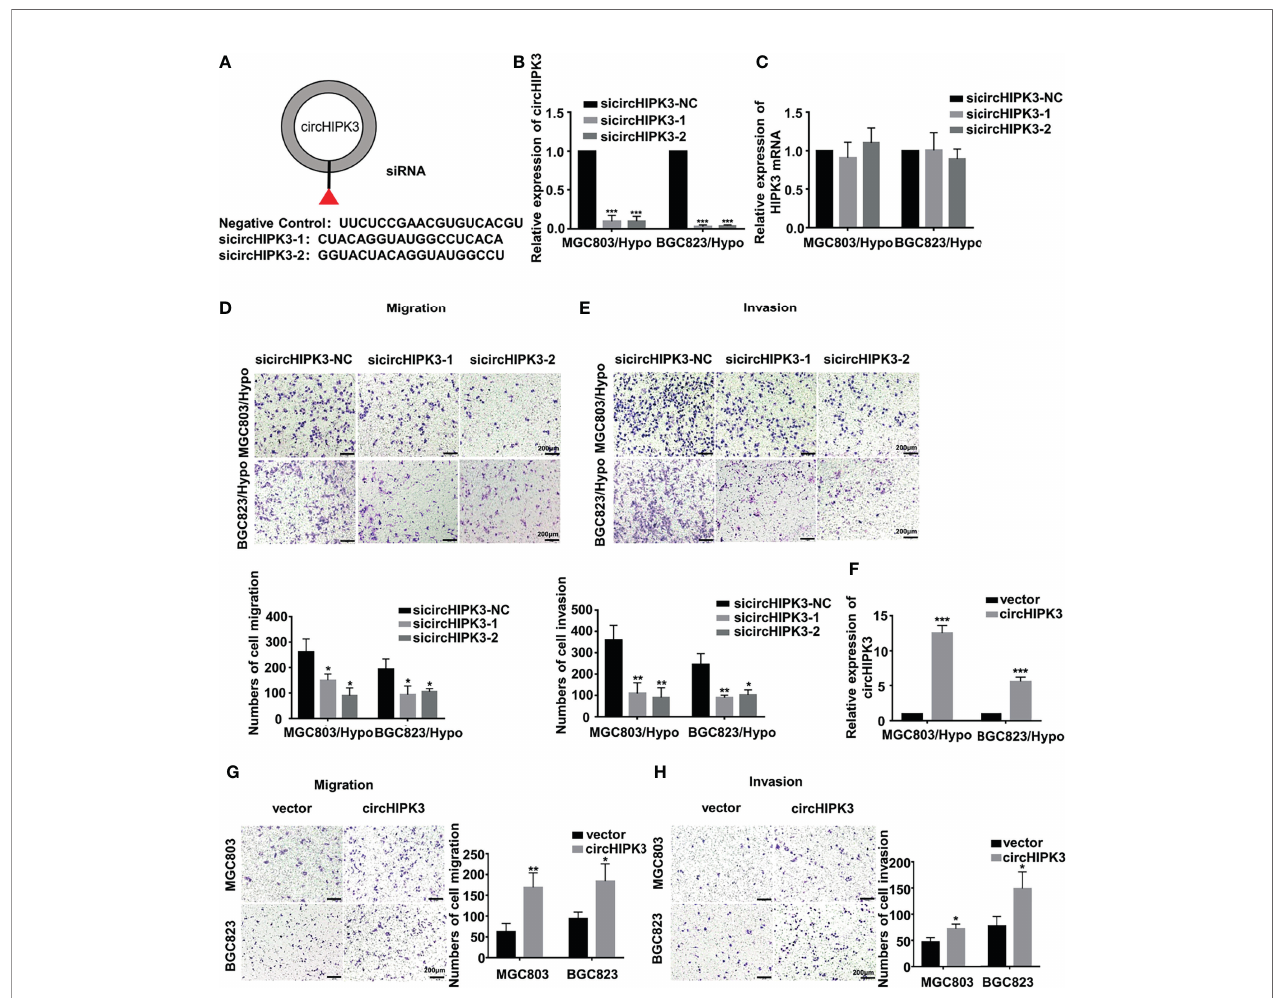
FIGURE 2 | CircHIPK3 promoted migration and invasion of HRGC cells. (A) The sequence of two siRNAs targeted to back-splicing site of circHIPK3 and the negative control siRNA. (B, C) The relative expression of circHIPK3 and linear HIPK3 mRNA in HRGC cells after transfected with negative control siRNA (siNC) or circHIPK3 siRNAs was detected by qRT-PCR. 18S was used as an internal control. (D, E) The migration and invasion ability of HRGC cells after transfected with siNC or circHIPK3 siRNAs was examined by transwell assay (original magni fi cation, 100×). The columns on the down panels are quanti fi ed by counting 3 fi elds, and presented as the mean ± standard deviation. *p < 0.05, **p < 0.01, ***p < 0.001. (F) The overexpression ef fi ciency of circHIPK3 in MGC803 and BGC823 cells was detected by qRT-PCR. 18S was used as an internal control. (G, H) The migration and invasion ability of MGC803 and BGC823 cells after transfected with circHIPK3 overexpression plasmids and empty vectors was examined by transwell assay (original magni fi cation, 100×). The columns on the right are quanti fi ed by counting three fi elds, and presented as the mean ± standard deviation. *p < 0.05, **p < 0.01, ***p < 0.001. Data are presented as the mean ± SD of three independent experiments. *p < 0.05, **p < 0.01, ***p <